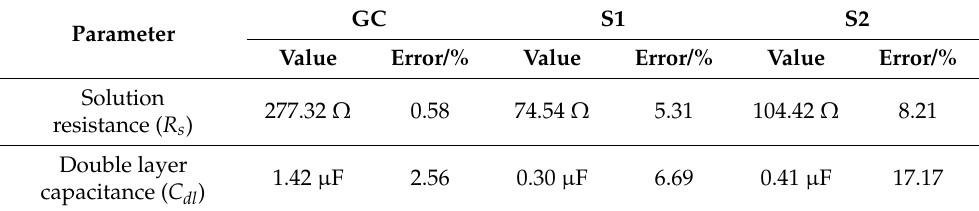
Table 2. Parameter values and errors for R s and C dl , determined by EIS fittings following an equivalent circuit as displayed in Figure